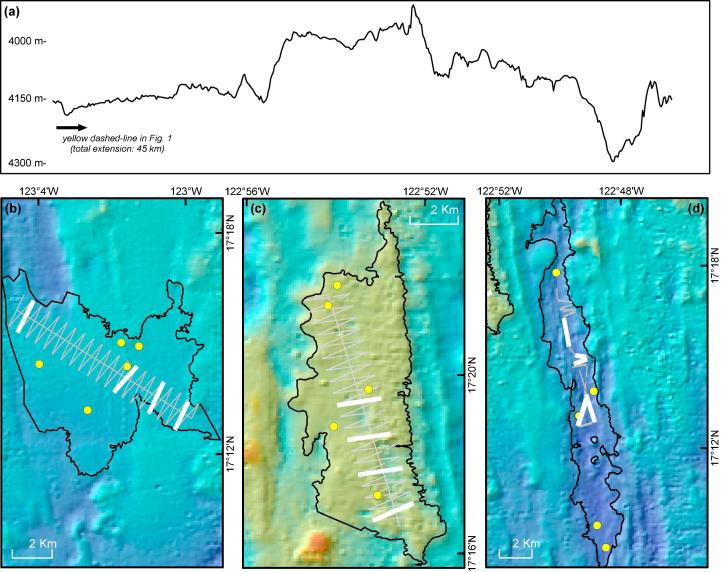
Survey Landscape type study areas investigated at the APEI6. (a) Seafloor bathymetric profile depicted as yellow-dashed line in Fig. 1. No vertical exaggeration was applied. b–d: Detail of sampling operations: grey lines indicate full AUV image survey tracks, thick white lines highlight replicate sampling units selected for analysis, and yellow dots represent coring stations. Study areas surveyed: (b) Flat area. (c) Ridge area. (d) Trough area. (For interpretation of the references to colour in this figure legend, the reader is referred to the web version of this article.)